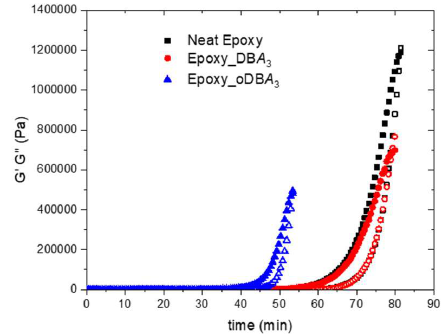
Figure 2. Storage (G', hollow symbols) and loss modulus (G", solid symbols) versus time for the pure EC01–isophorondiamine (IPDA) epoxy resin, (black color) and the 3 wt.% filler-based solutions: DBA and oDBA (red and blue color, respectively).